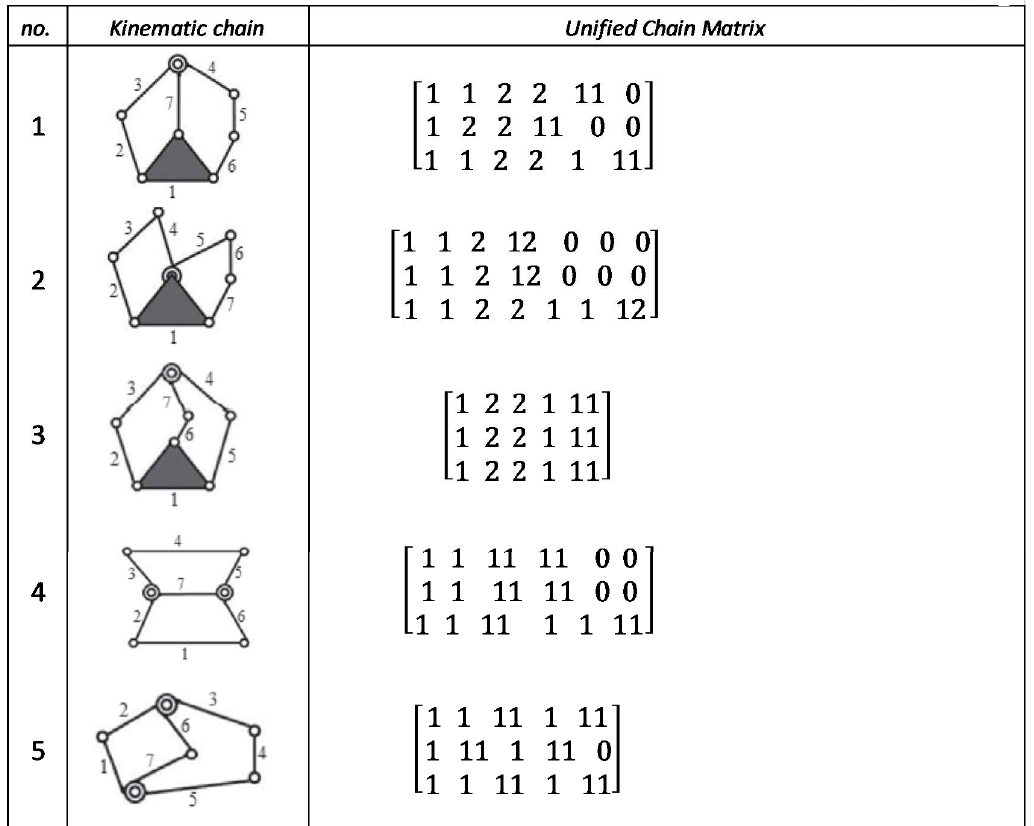
Figure A3. Unified chain matrix, UCM, for all 7 links 2-DOF KCs with 1, 2 multiple joints [40].